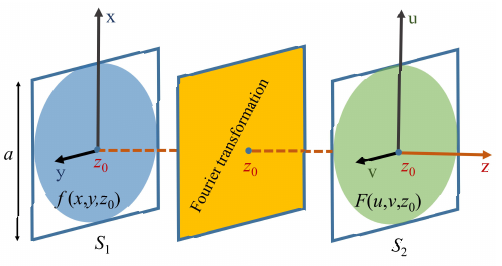
Figure 1. Geometry of the